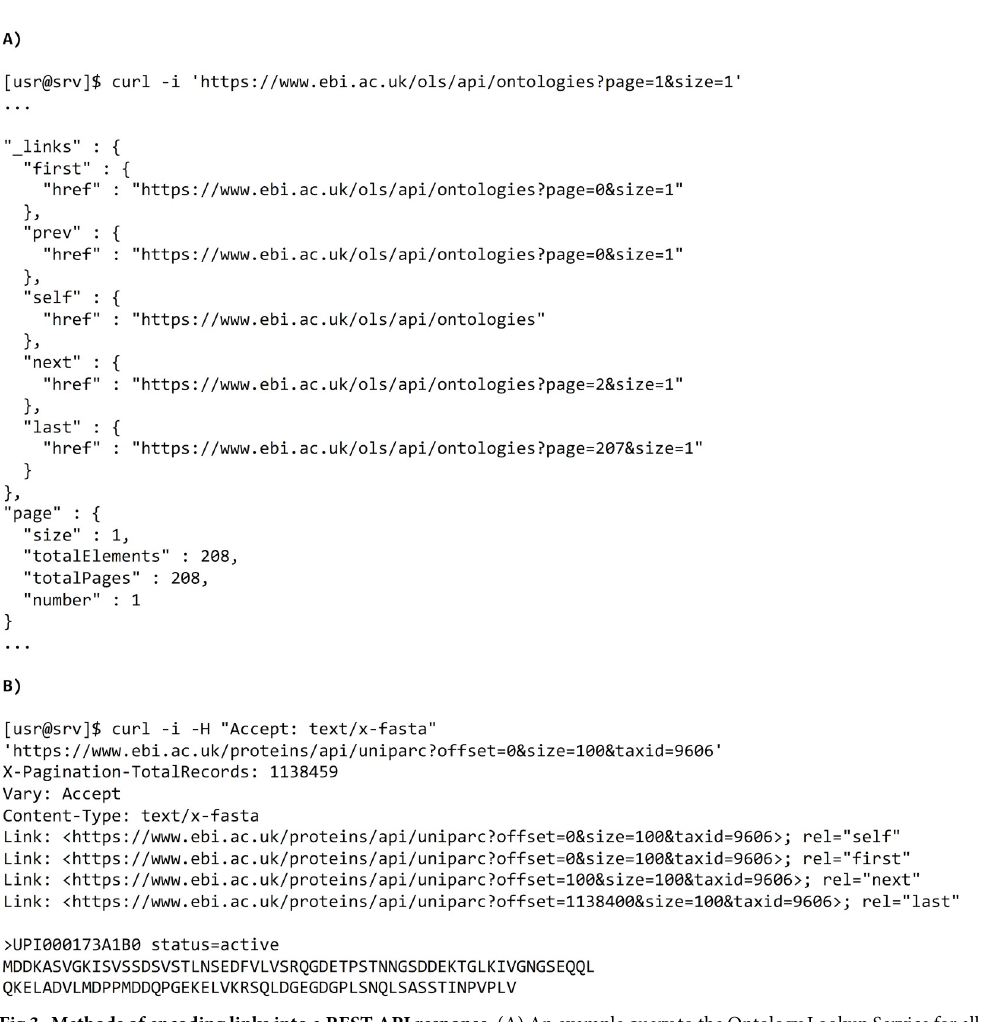
Fig 3. Methods of encoding links into a REST API response. (A) An example query to the Ontology Lookup Service for all available ontologies. The response lists links to access the first, previous, next, and last pages (including supplementary metadata) of the entire collection. (B) An example query to the Proteins REST API to retrieve all sequences in FASTA format. Links are encoded in the Link HTTP response header to be parsed by a client. API, application programming interface; HTTP, hypertext transfer protocol; REST, representational state